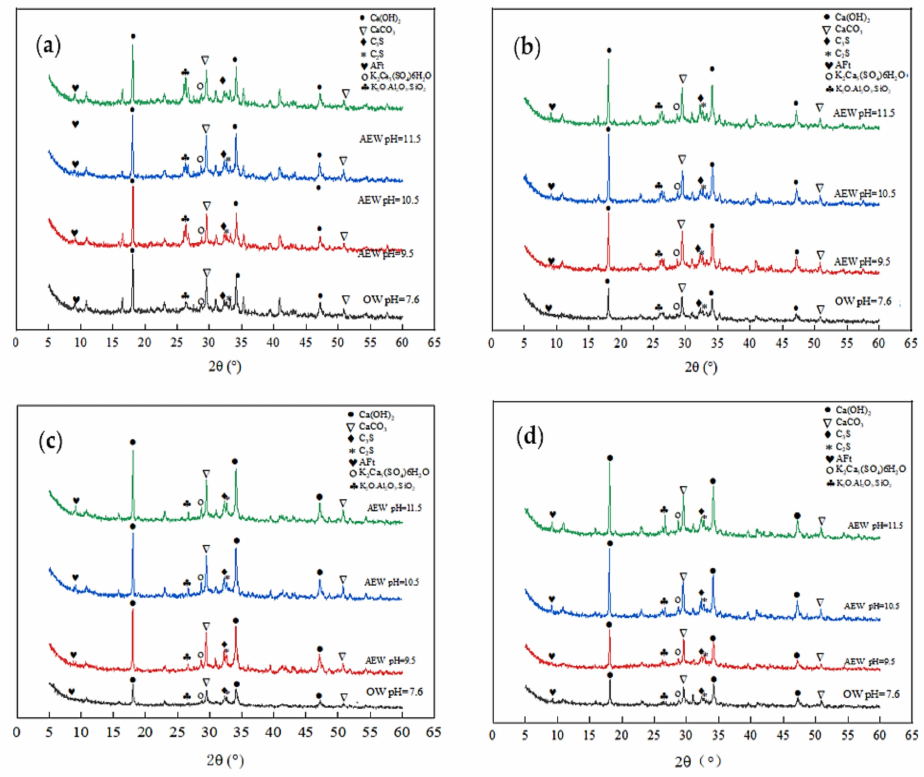
Figure 7. Diffraction pattern of XRD at 28 d: ( a ) FA = 0; ( b ) FA = 15%; ( c ) FA = 30%; ( d ) FA =